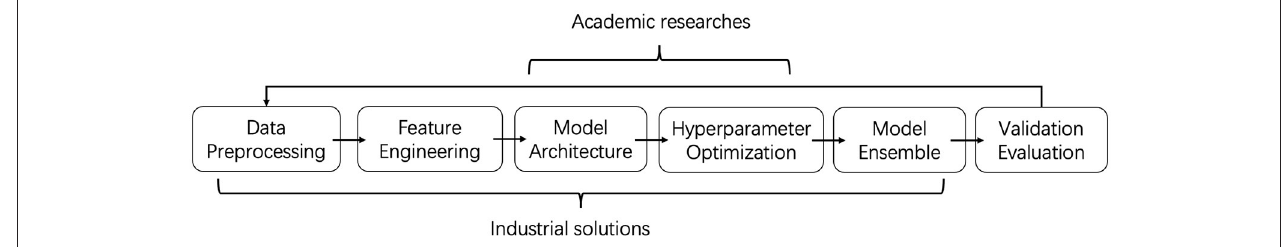
FIGURE 1 | Illustration of AutoGraph scope. Industrial people provide a full pipeline solution that covers data preprocessing to evaluation. Academic researchers focus mainly on model architecture and hyperparameter optimization.